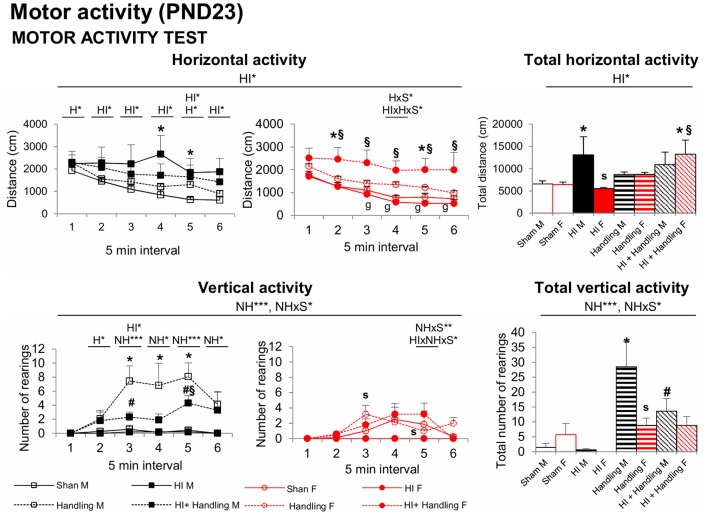
Spontaneous motor ACT: short- and long-effects of HI in males and females C57BL6 and effects of NH. Motor activity (PND23). Horizontal activity in ACT was increased in HI males and HI + NH females; however, the vertical activity was higher in handling males. Statistics: RMA, two-way ANOVA: “HI” Hypoxia effect; “NH” handling effect; “S” sex effect; “A” age effect *P < 0.05, **P < 0.01, and ***P < 0.001, followed by Duncan’s post hoc test. *P < 0.05 vs. sham of the same sex; #P < 0.05 vs. handling of the same sex; §P < 0.05 vs. hypoxia of the same sex; sP < 0.05 female vs. male of the same treatment.